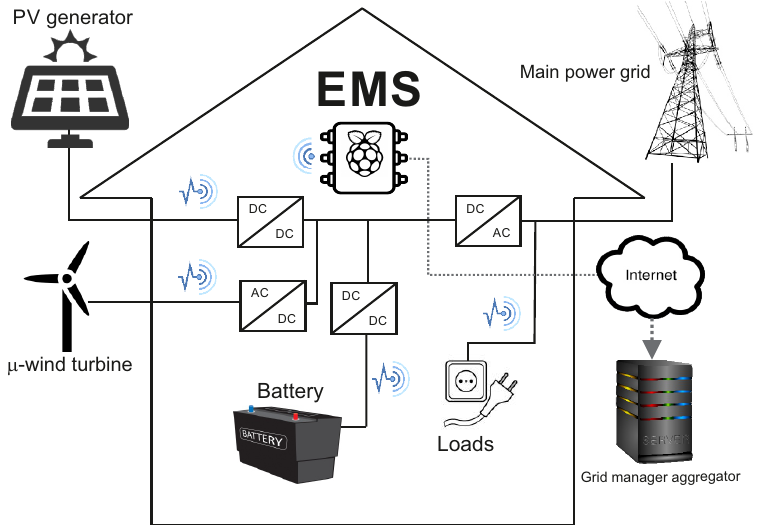
Figure 2. Pictorial view of the smart home under